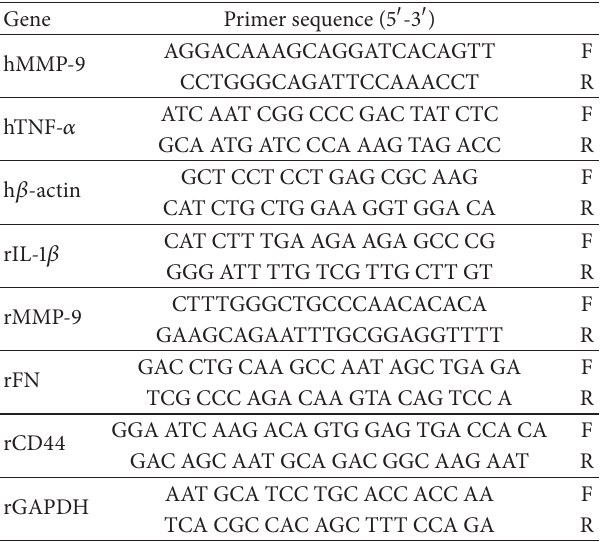
Table 1: Nucleotide sequences of the specific primers used for PCR